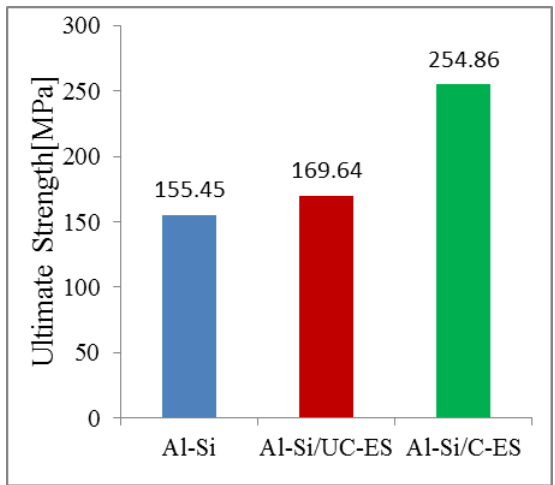
Fig. 13. Comparison of ultimate compressive strength of control sample and the two